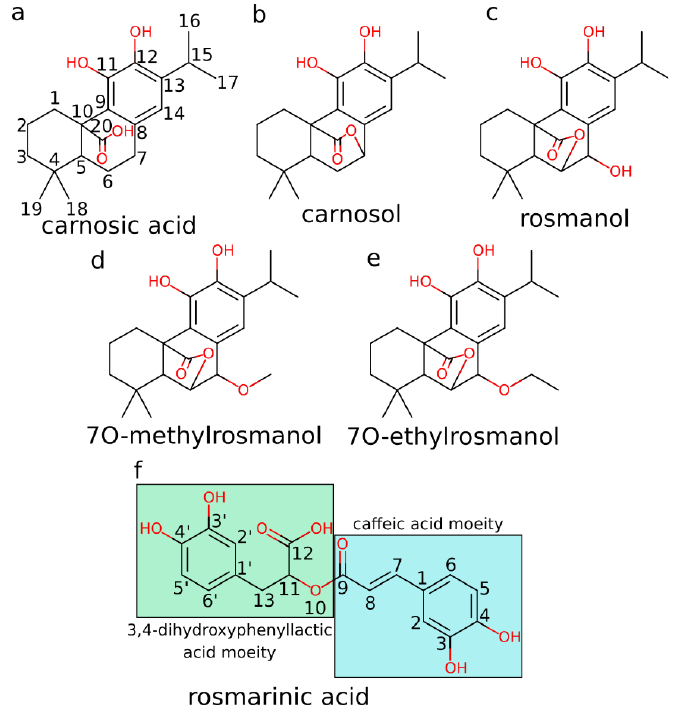
Figure 1. The 2D structures and atom numbering of investigated compounds: ( a ) carnosic acid, ( b ) carnosol, ( c ) rosmanol, ( d ) 7O-methylrosmanol, ( e ) 7O-ethylrosmanol, and ( f ) rosmarinic acid.